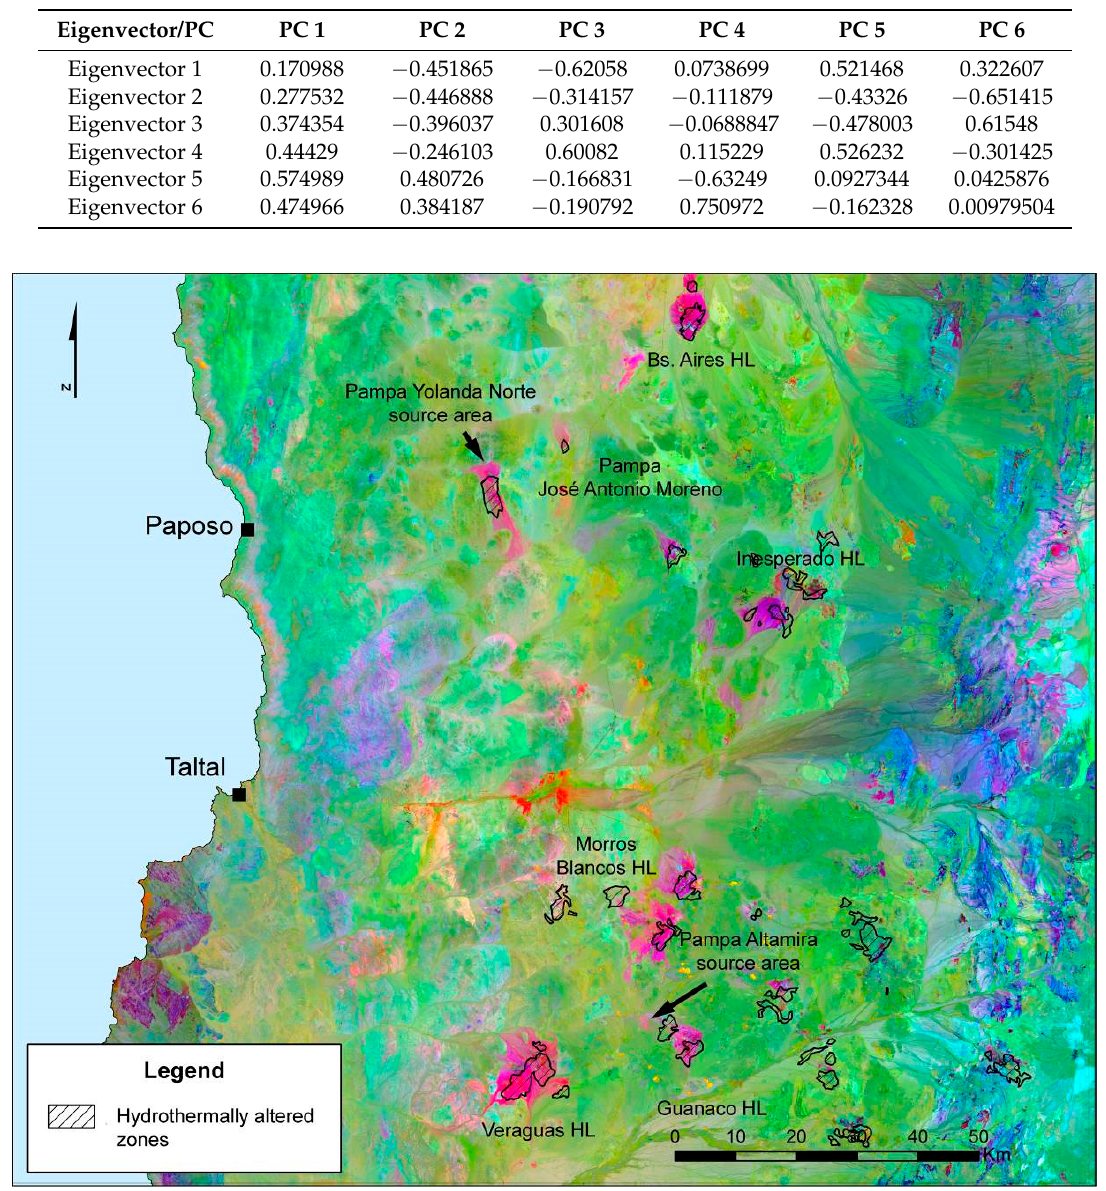
Table 1. Eigenvector matrix of Landsat 8 VNIR bands PCA.